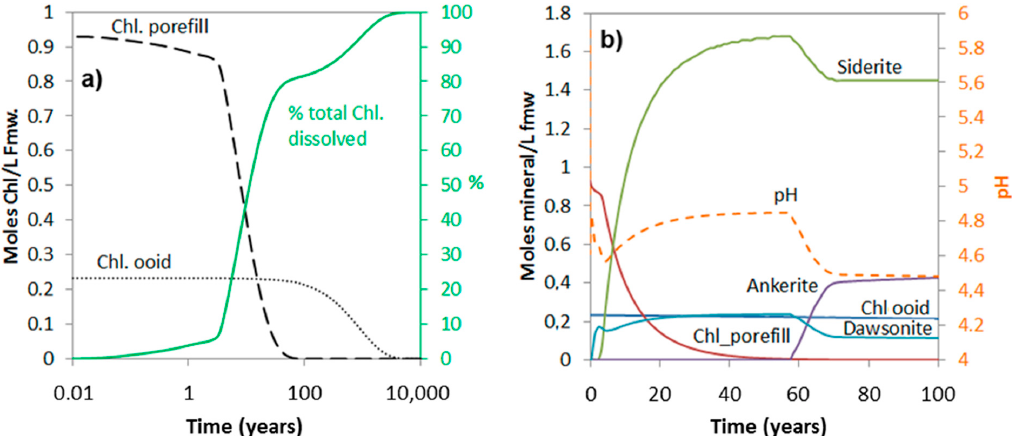
Figure 7. Simulated chlorite dissolution ( a ), and corresponding secondary carbonate formation and pH (dotted curve) evolution ( b ), for 100 years of CO 2 -chlorite interactions with initial materials consisting of 20% chlorite as ooids, and the remaining fraction as high-reactive pore-filling or grain-coating materials.